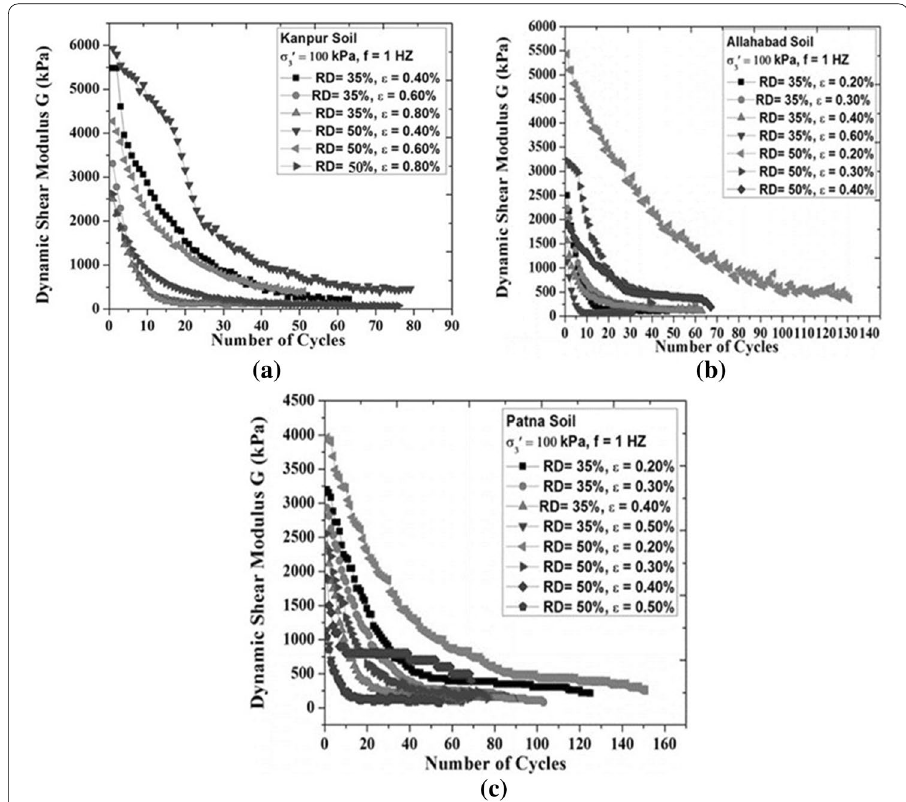
Fig. 10 Variation of shear modulus with number of loading cycle. a Kanpur cycle, RD amplitude 0.40%, 0.60%, 0.80%, effective confining pressure = RD 35%, 50%, strain amplitude 0.20%, 0.30%, 0.40%, effective confining pressure = = 1 Hz. c Patna soil, RD 35%, 50%, strain amplitude = = pressure 100 kPa, frequency 1 = =